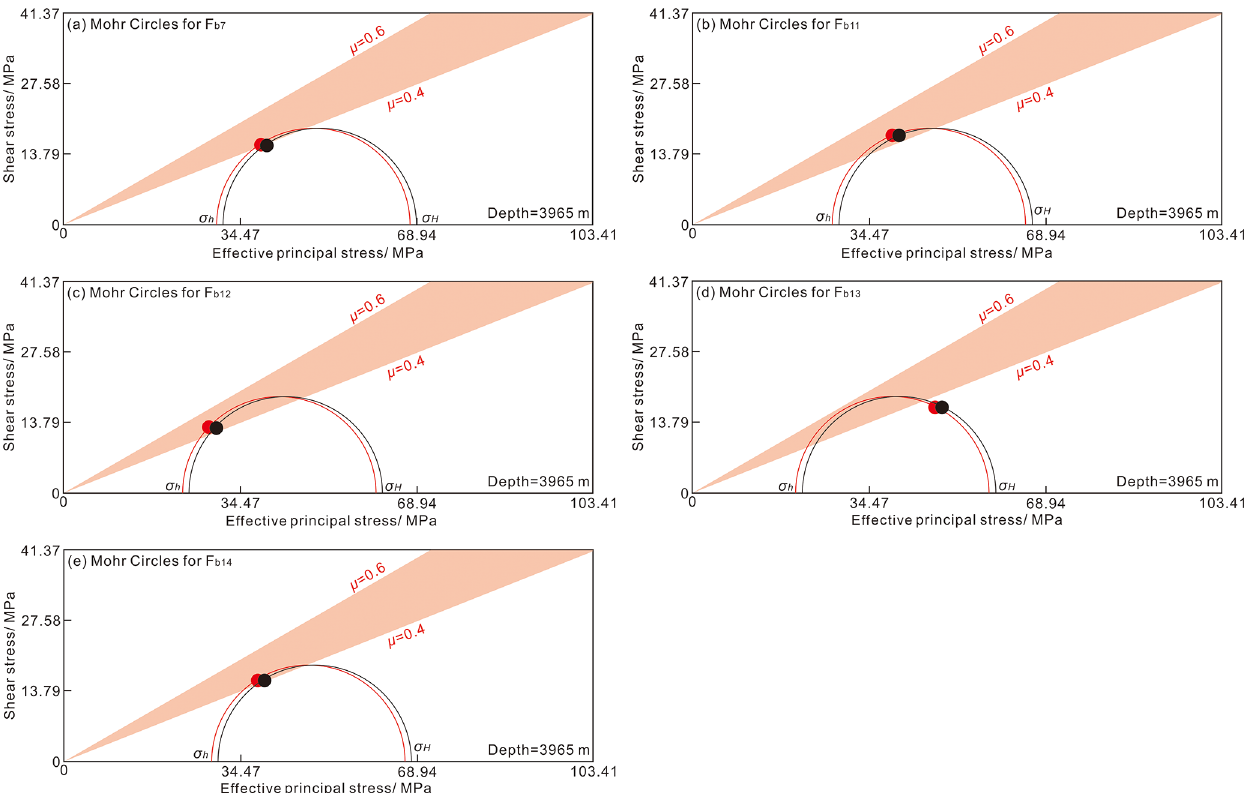
Figure 16. The effect of thermoelastic stress on fault instability of the mapped faults F b11 , F b12 , F b12 , F b13 , and F b 14 , within a range of ∼ 6–10km away from the MTY EGS field. The changes in horizontal stress are calculated for a temperature drop of 6 ◦ C with a value of 1.25MPa. The black dot marks the traction of fault instability (a horizontal distance to slip in megapascals) without the influence of thermoelastic stress, while the red dot marks the traction of the fault instability with the effect of temperature-induced stress changes.